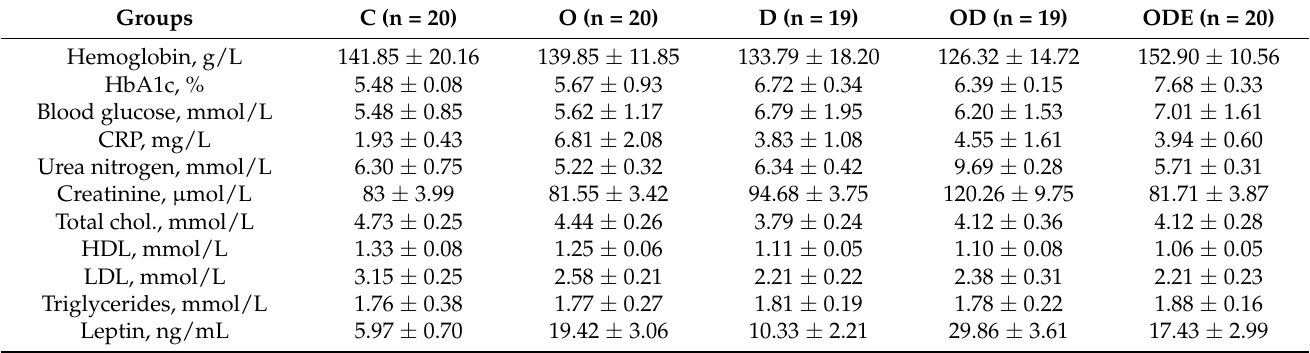
Table 2. Laboratory parameters in the different groups. C = control group, n = number of patients, O = obese group, D = diabetic group, OD = obese diabetic group, ODE = obese diabetic group treated with empagliflozin, g = gram, L = liter, mmol = millimole, mL = milliliter, CRP = C-reactive protein, mg = milligram, µ mol = micromole, Total chol. = total cholesterol, HDL = High-density lipoprotein cholesterol, LDL = Low-density lipoprotein cholesterol, ng =